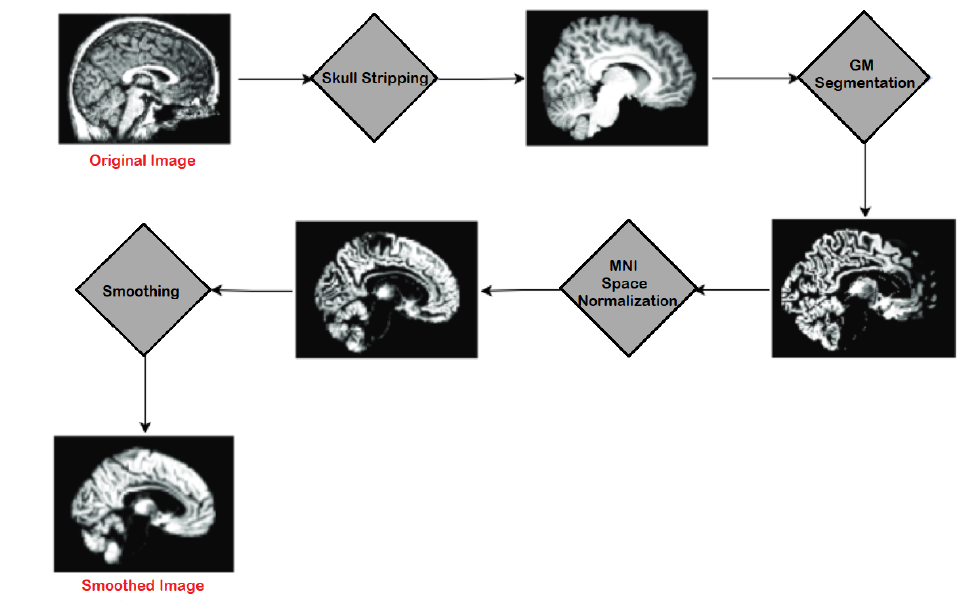
Figure 4. Major Steps of Pre-processing on